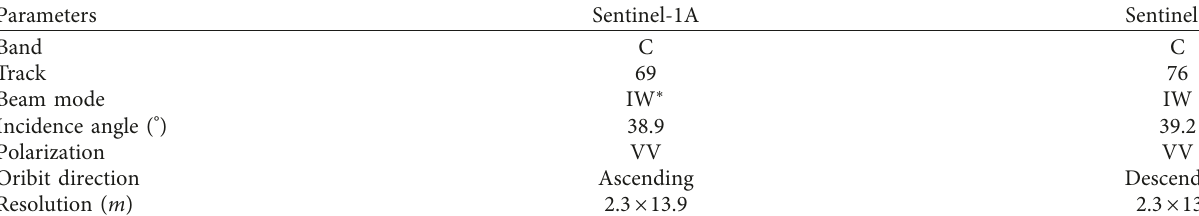
Table 1: Parameters of Sentinel-1.